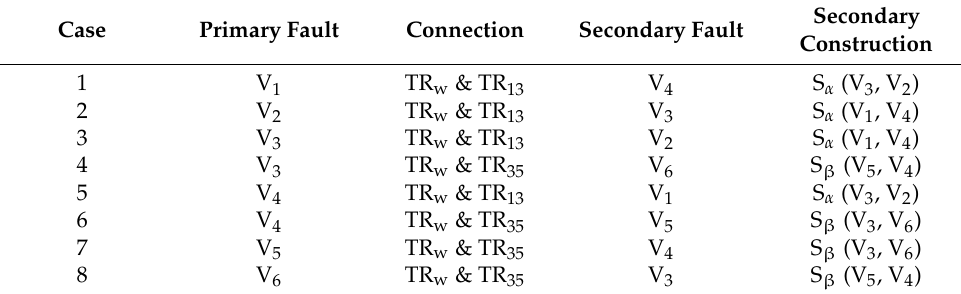
Table 4. Secondary reconfigurable inverter switching